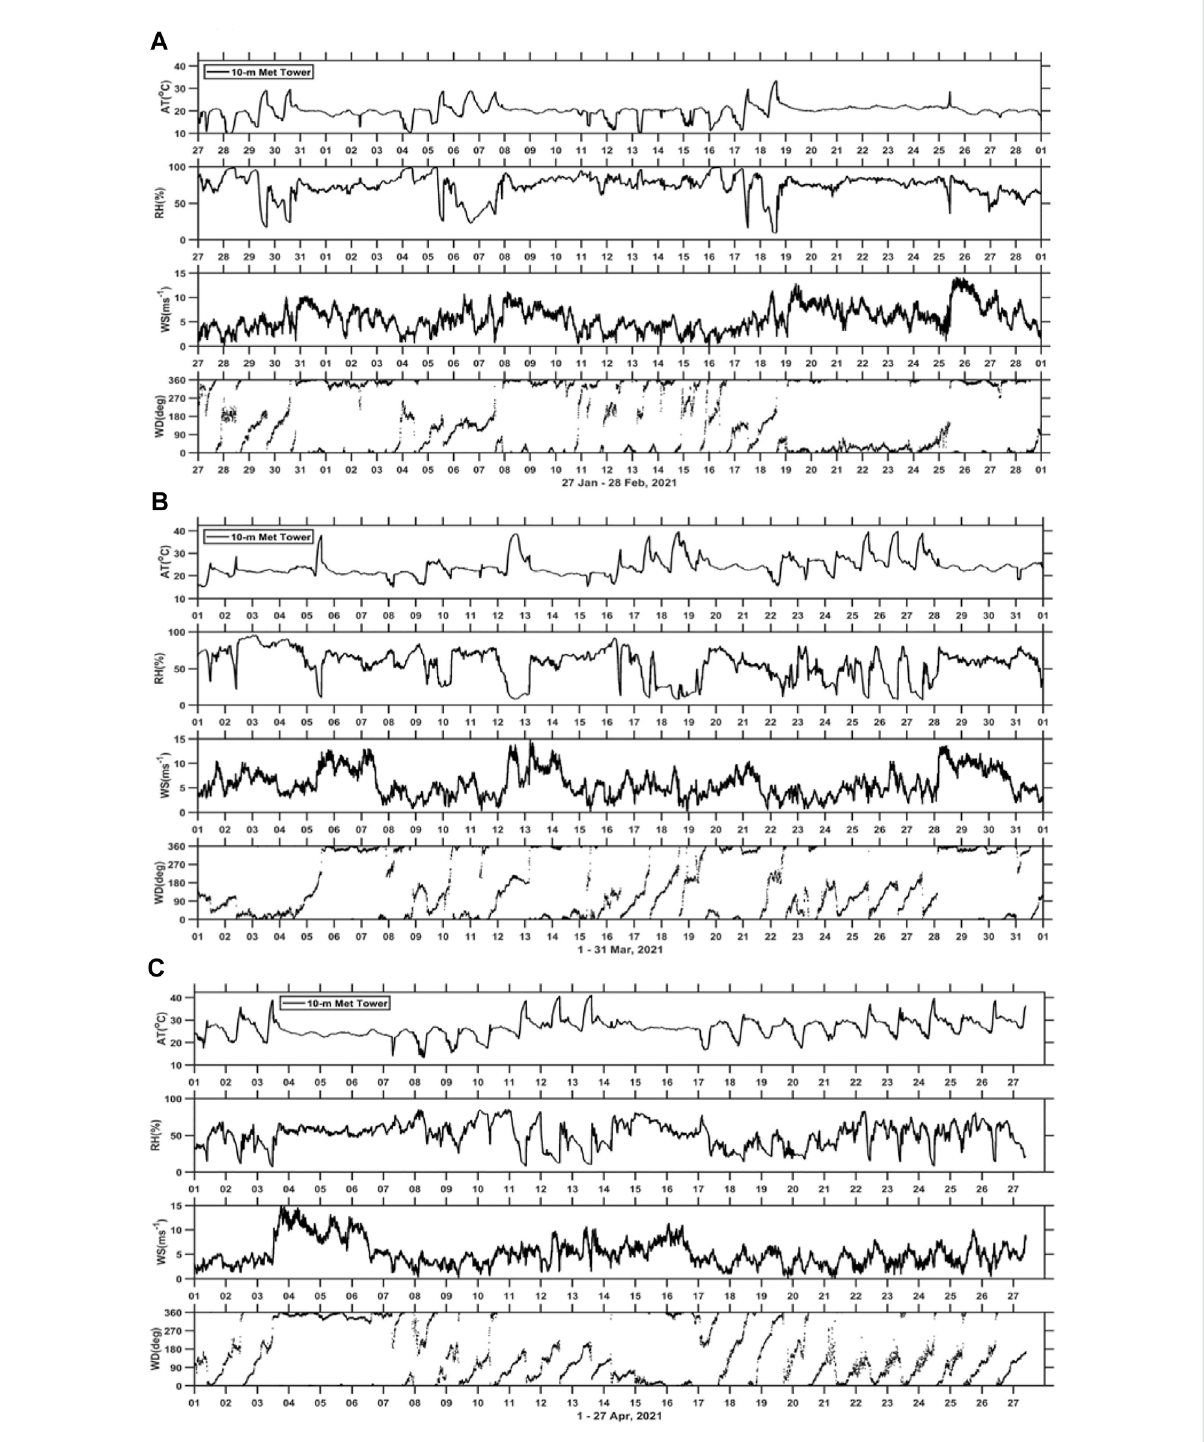
FIGURE 6 Panels from top to bottom: Air temperature( ° C), relativehumidity (%), horizontal wind speed(m s-1) andwind direction( ° )fromthe10-m tower (green pin in Fig. 1c) for the periods 27 January to 28 February 2021 (A) , 1 to 31 March 2021 (B) and 1 to 27 April 2021 (C)